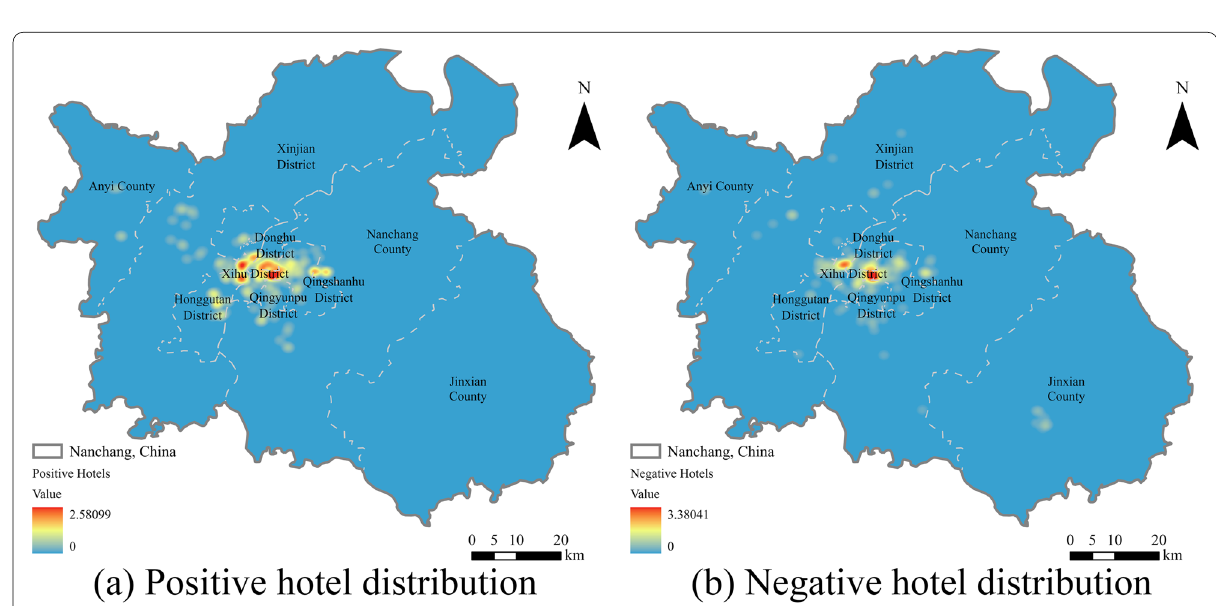
Fig. 7 Spatial distribution of positive and negative hotel kernel